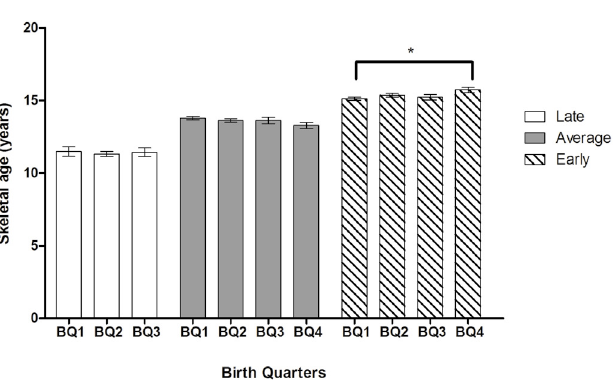
Figure 1. Age-adjusted mean ± standard error for skeletal age (SA) within each skeletal maturity status by birth quarters in young soccer players.